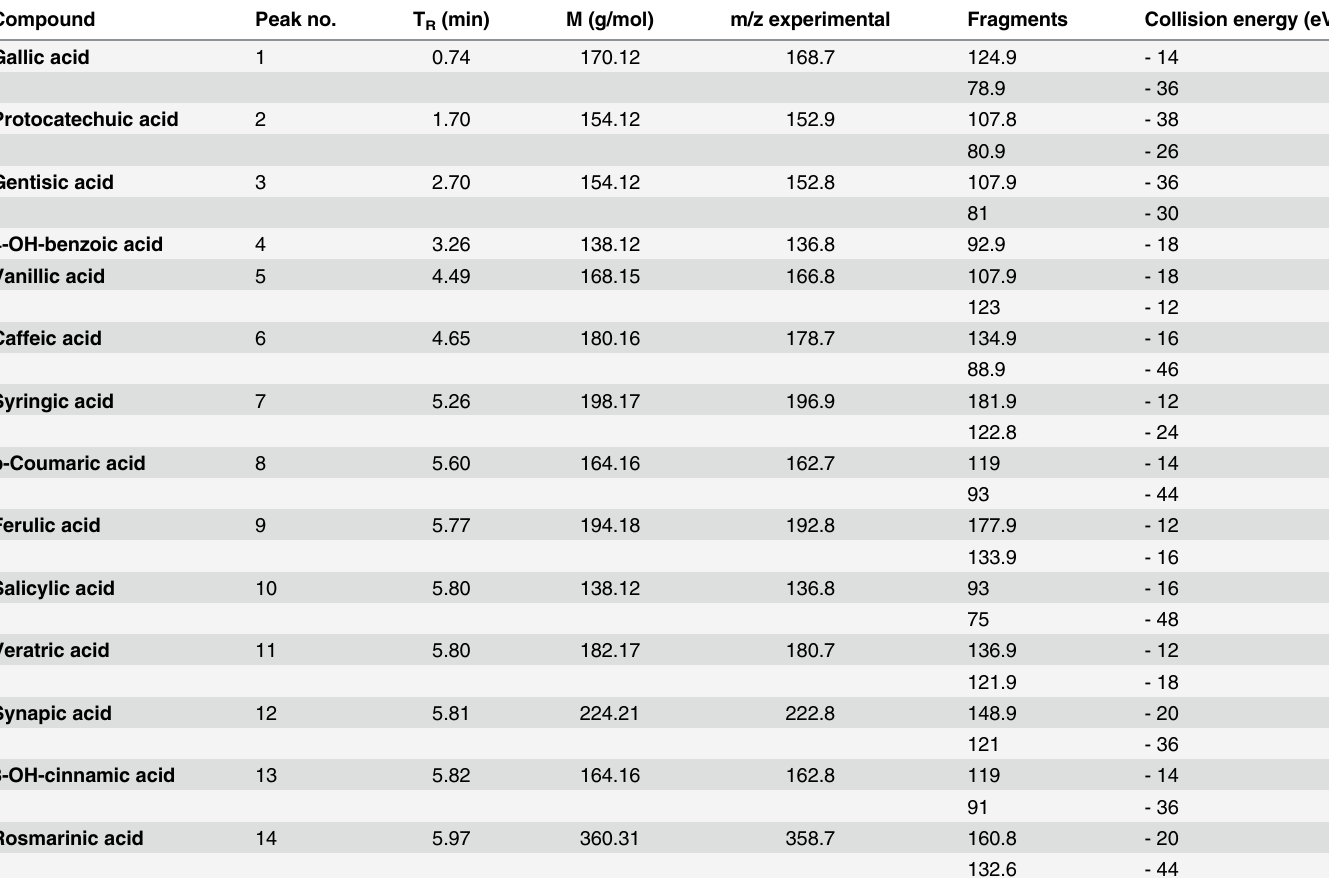
Table 2. LC-ESI-MS/MS analytical results of phenolic acids investigated in mushroom extracts, including retention times, molecular masses, mass-to-charge ratio (m/z) and fragments obtained with given collision energy. Compounds confirmed by comparison with authentic standards. Compound